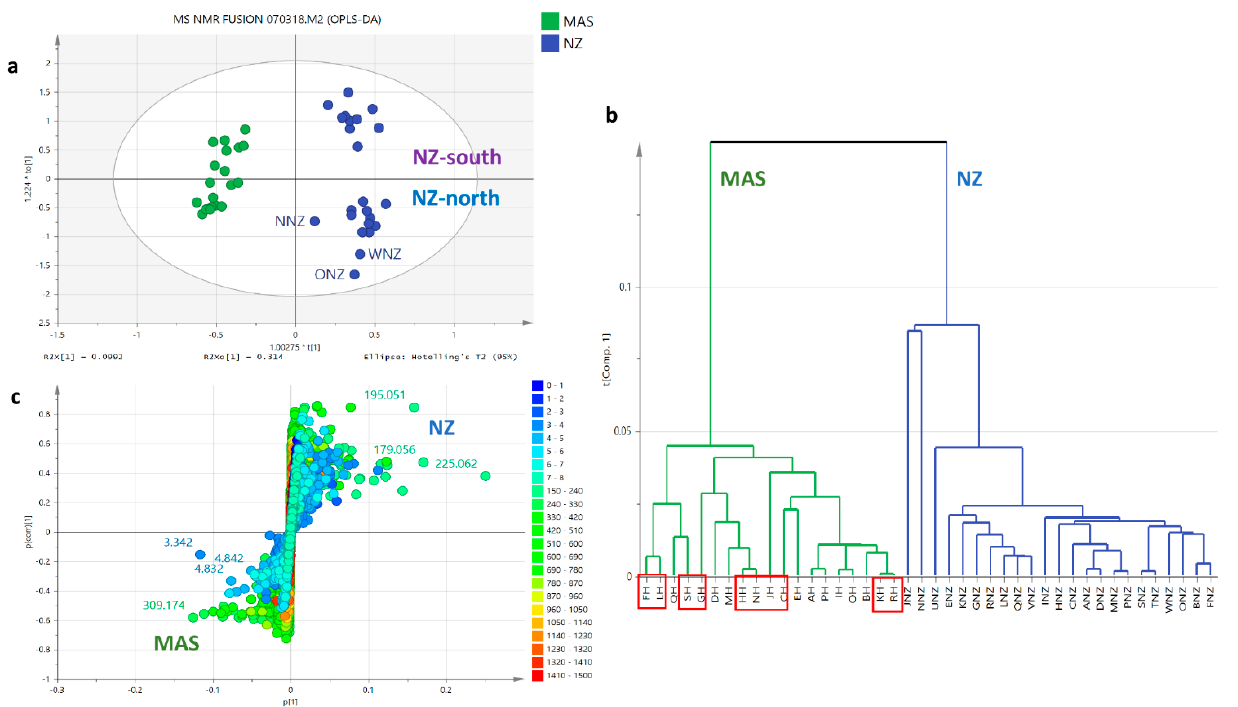
Figure 7. OPLS model employing fused NMR and mass spectral datasets. Bioactive extracts were boxed in red. ( a ) OPLS-DA scores plot (R 2 = 0.997 and Q 2 = 0.974). Permutation test generated a Q 2 Y = − 0.473, ( b ) HCA by single linkage, and ( c ) S-loadings plot of 1 H NMR and mass spectral data of honey extracts. (R 2 = 0.96 and Q 2 = 0.74). Legend: MAS (Malaysian samples), NZ (New Zealand samples, color codes on S-plots are indicated by their chemical shifts in ppm values from 0 to 8 ppm and ion peaks at m/z from 150 to 1500 Da.